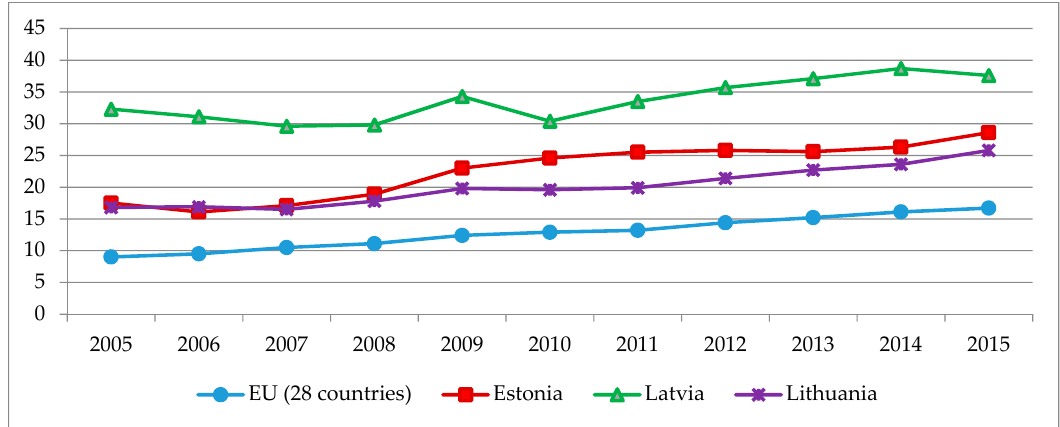
Figure 8. Share of renewable resources in gross final energy consumption, %.